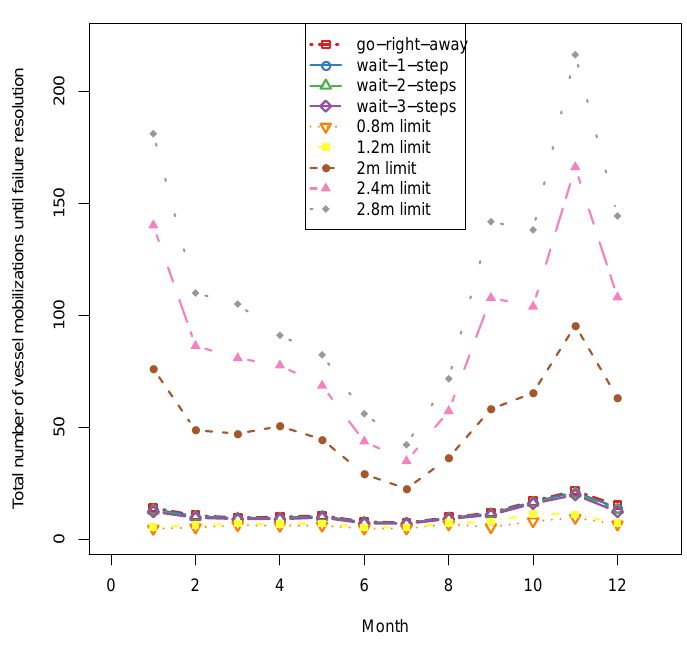
Figure 8. Total number of vessel accesses until the major blade repair is completed—for different